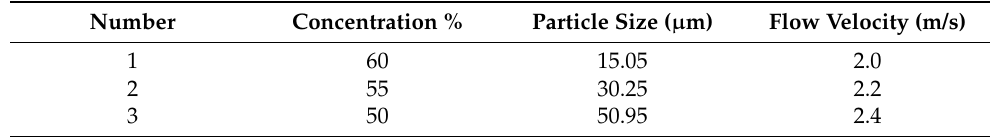
Table 2. Simulation test plan parameters.